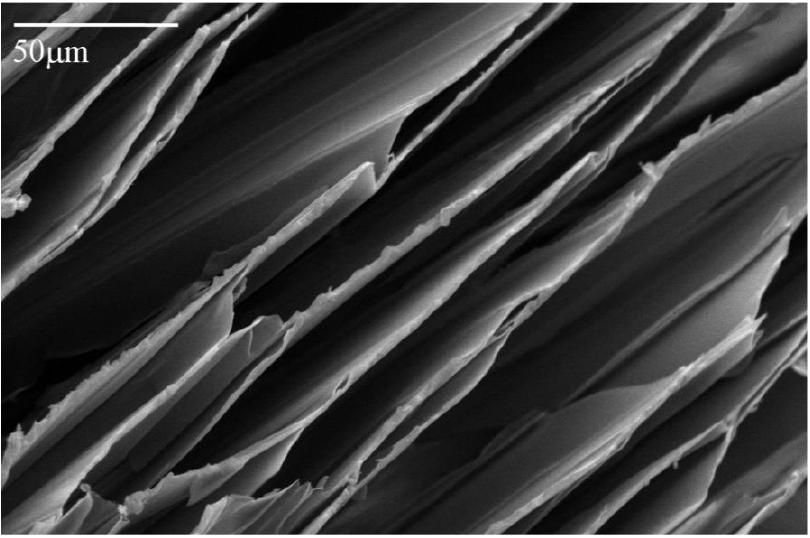
Figure 7. SEM image of the microstructure of a 5 wt.% AI-30 Composite with 2 equivalents of amine.